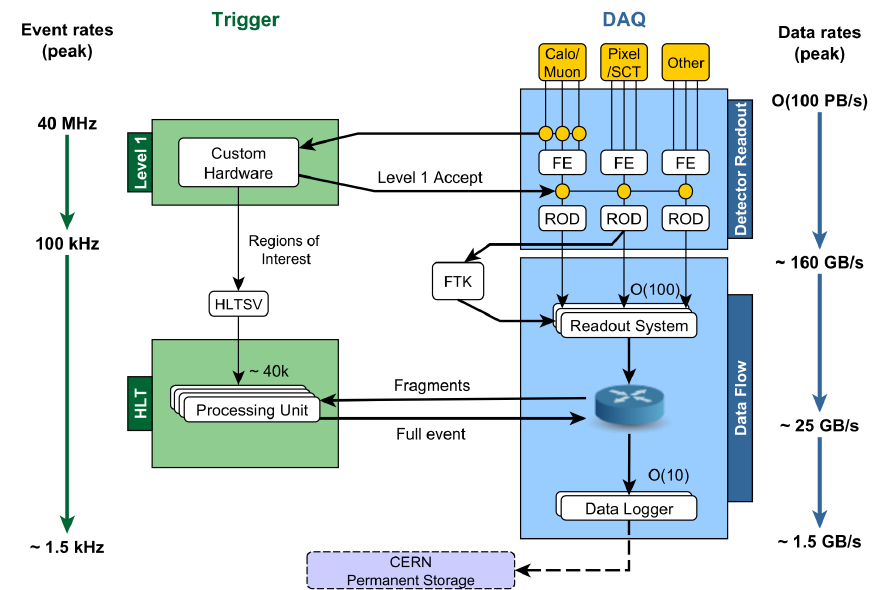
Figure 2. The ATLAS DAQ System in LHC Run 2